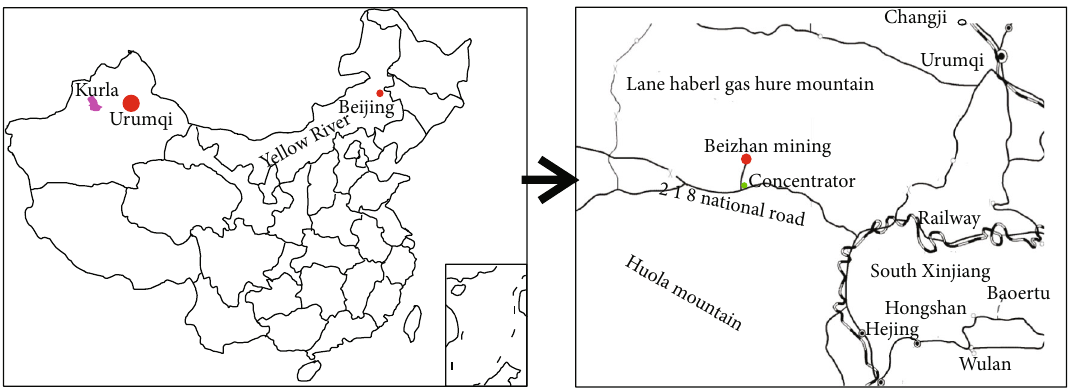
Figure 1: Location of the Hejing Beizhan Iron Mining in the Xinjing province, China.